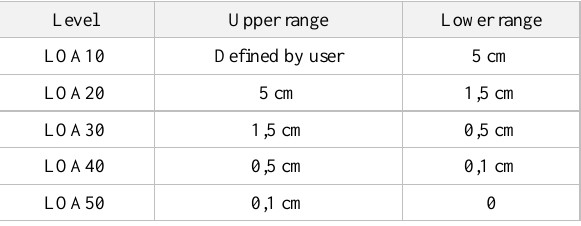
Table 1 . The LOA classification provided by USIBD.